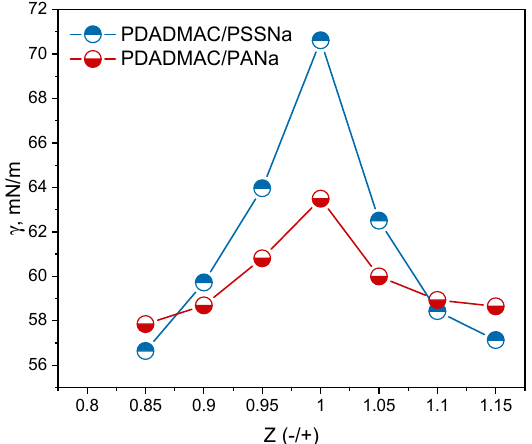
Figure 6. Surface tension ( γ ) measurements of the supernatant of PEC dispersions at different charge ratios (Z) around the charge stoichiometry (Z = 1) for PDADAMAC/PANa and PDADMAC/PSSNa. PECs were prepared from 18.6 mM PE solutions, the supernatants were collected after a complete macroscopic phase separation (2 weeks), and the surface tension was measured after 500 min when the signal became constant.